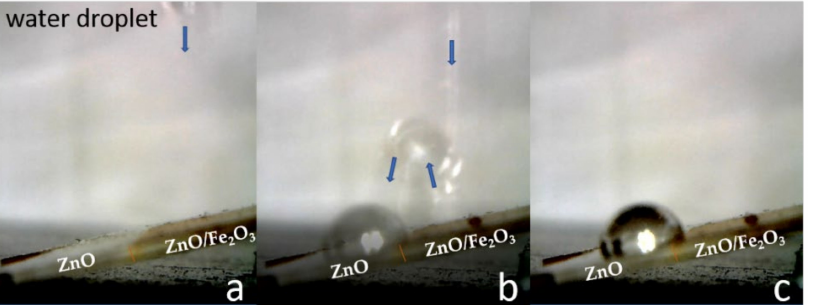
Figure 6. Investigation of the sliding angle of a water drop from the surface of a type II ZnO sample covered with a Fe 2 O 3 layer. The arrows indicate the trajectory of the water drop. Sample inclination angle—9 ◦ . Measurement time: ( a ) 0 s, ( b ) 1s, ( c )